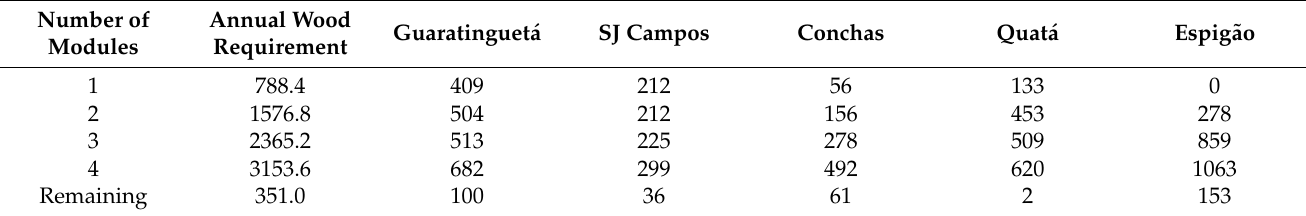
Table 3. Annual wood demand (dry basis—10 3 t) as a function of the number of modules of the technology FT-SPK and the estimated contribution (also in 10 3 t · year − 1 ) of each of the five sites of production.